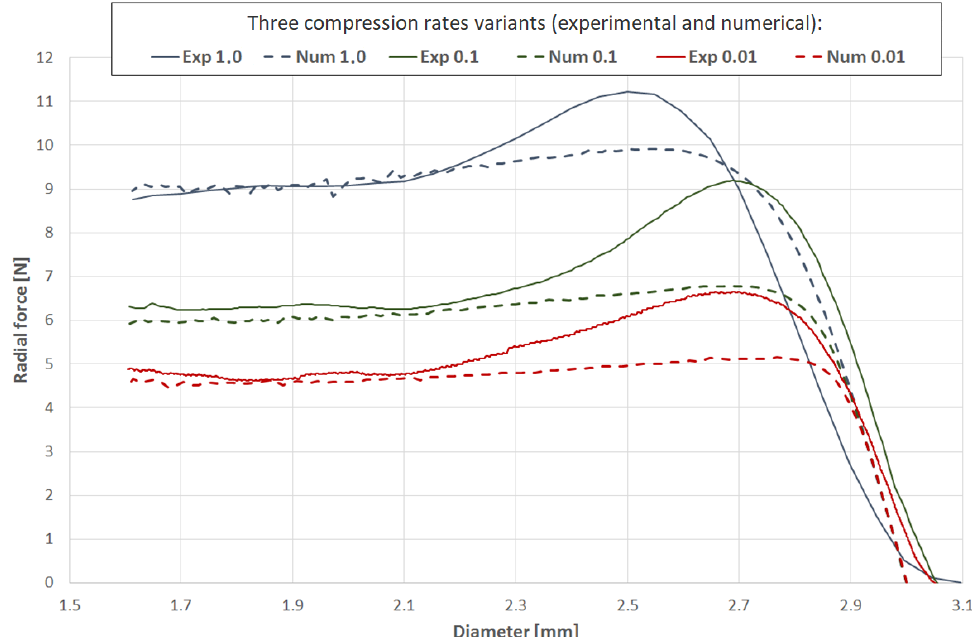
Figure 12. Comparison of experimental and numerical results for radial forces during free compression of undeformed coronary stents made of PLGA bioresorbable polymer with three compression rate variants: 1.0 mm/s, 0.1 mm/s, and 0.01 mm/s.